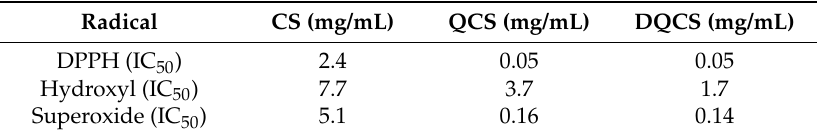
Table 1. Antioxidant activity of chitosan